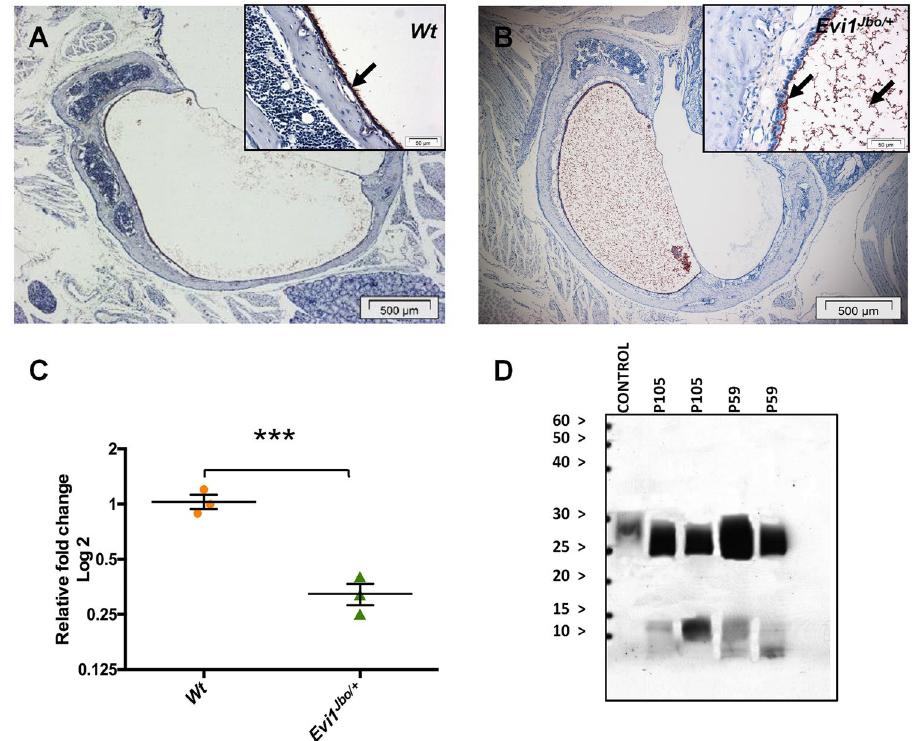
Figure 3. Analysis of BPIFA1 levels in the Evi1 Jbo/ + middle ear. IHC analysis of P28 ME sections representative of n = 3 mice showing abundant staining of BPIFA1 along the WT ME epithelium ( A ) and reduction in staining intensity along Evi1 Jbo/ + ME epithelium, but positive staining in the exudate ( B ). Arrows indicate positive staining; Scale bar: 500 μ m for 4x objective images and 50 μ m for 60x objective images (insets). RT-qPCR analysis of freshly isolated mouse ME mucosal epithelial cells (mMMCs) show a significant downregulation of Bpifa1 in Evi1 Jbo/ + mucosa compared to WT mucosa. Data represented as individual RQ values ± SEM for three independent batches of freshly isolated mMMCs (each batch contains cells pooled from 6 mice). *** p < 0.001, 2 tailed t-test ( C ). BPIFA1 is readily detected in the ME effusion of Evi1 Jbo/ + mice by Western blot ( D ). Ear exudates from two different P105 and P59 animals showed presence of the full-length protein (25 kDa) along with partially degraded peptides. The control (BAL fluid from scgb1a1- scnn1b transgenic mice) showed presence of only the full-length